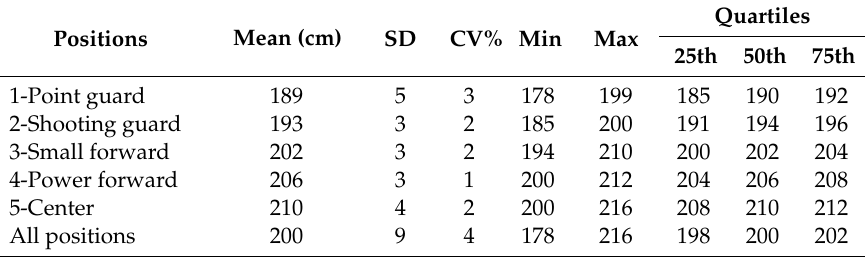
Table 3. Descriptive statistics for each position for the teams that ranked 1–16.